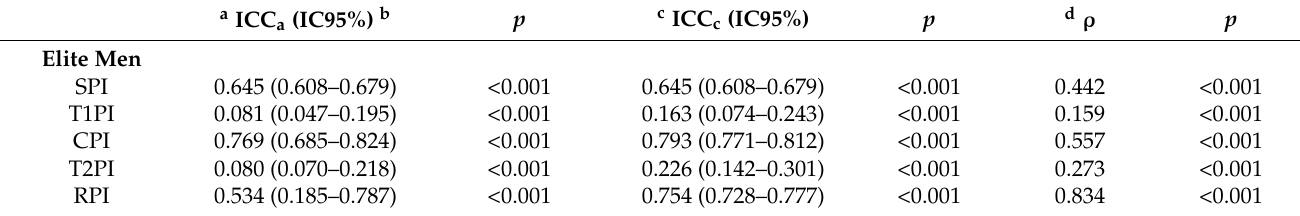
Table 2. Random selection of the subsample representing 25% of the total